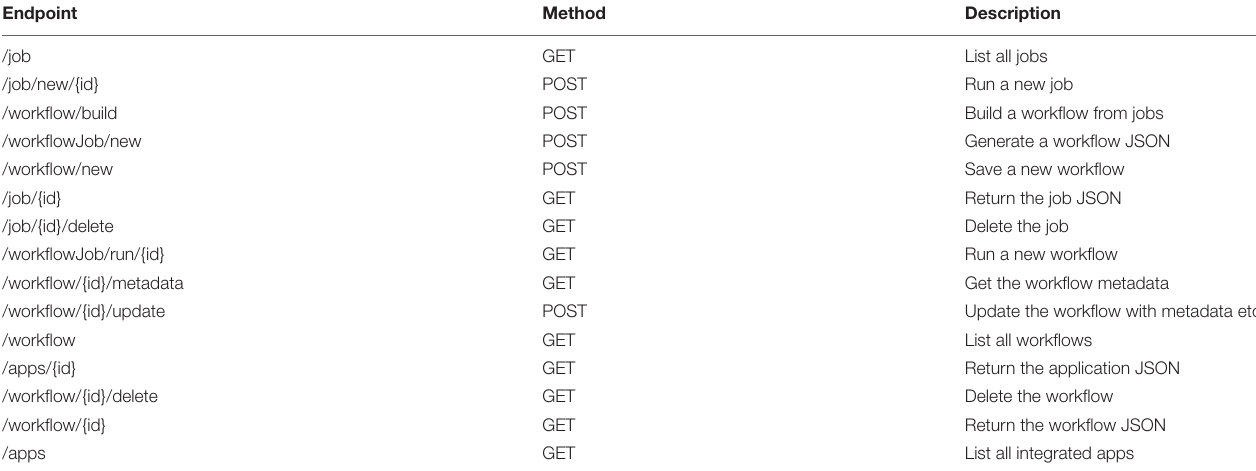
TABLE 1 | SciApps release 1.0 RESTful API.